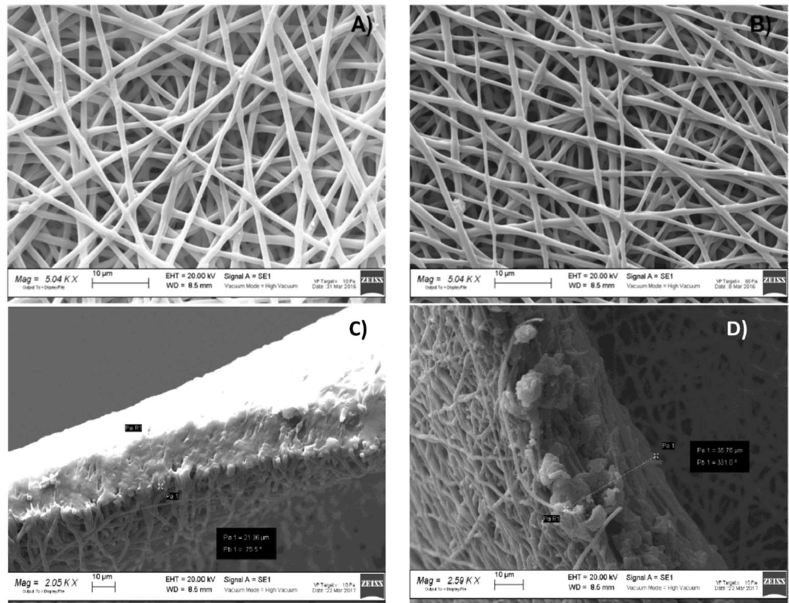
Figure 6. Scanning Electron Microscopy (SEM) images of ( A ) PLA-PCL electrospun matrices (magnification 5.04 KX); ( B ) PLA-PCL / GS electrospun matrices (magnification 5.04 KX); ( C )